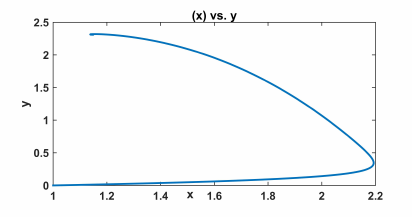
Figure 22. Recovery variable (right) with a constant external current value, I(t) = 5 µ A / cm 2 , a = 0.8 , b = 0.7 & c =